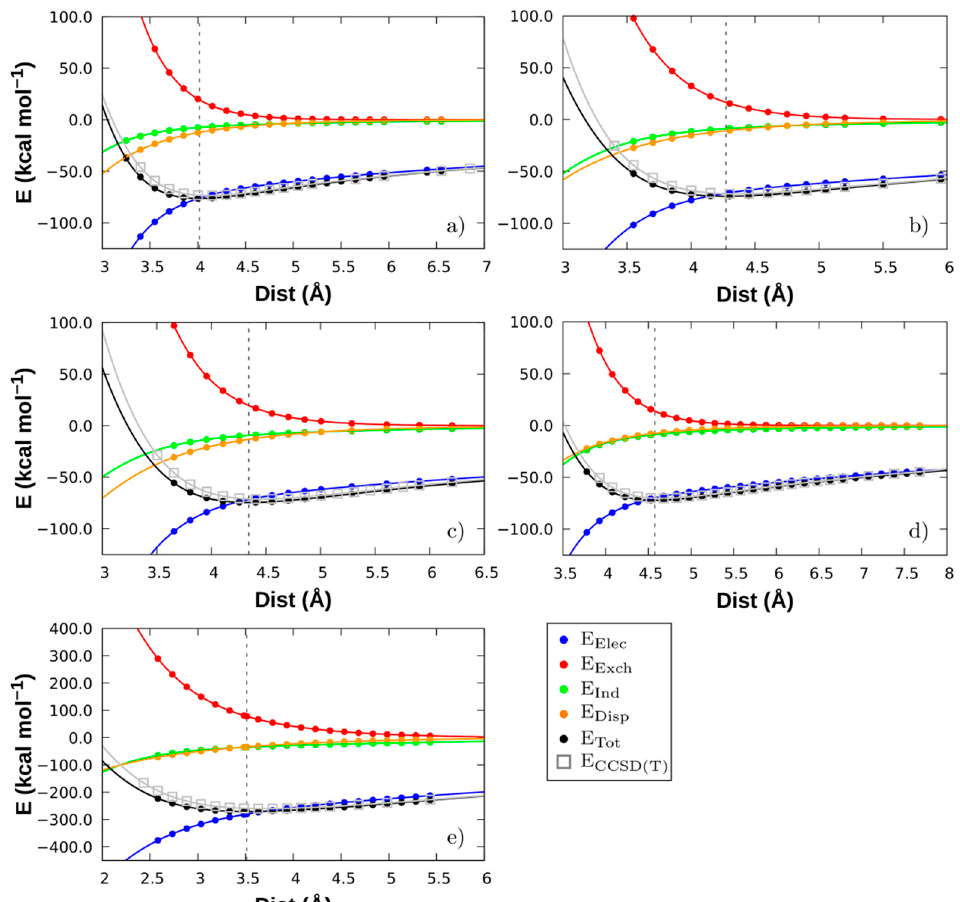
Figure 4. SAPT0 decomposition for an increase distance between the monomers. The LED-DLPNO- CCSD(T) energy is included for comparison purposes. ( a ) [Emim][FeCl 4 ], ( b ) [Bmim][FeCl 4 ], ( c ) [Bmim][FeBr 4 ], ( d ) [Bmim][ZnCl 3 ], ( e ) [Bmim] 2 [SnCl 4 ].